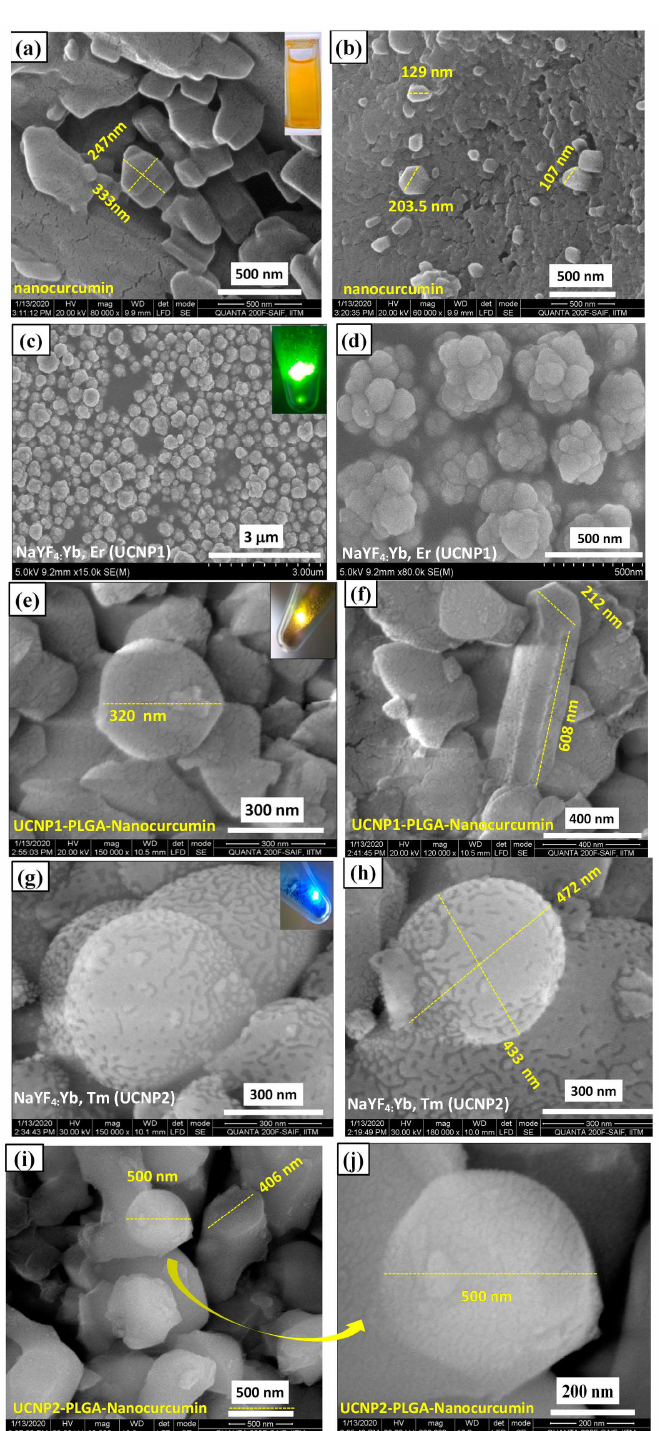
Figure 2. HRSEM images of nanocurcumin ( a , b ) , UCNP1 ( c , d ), UCNP1-PLGA-nanocur ( e , f ), UCNP2 ( g , h ), and UCNP2-PLGA-nanocur ( i , j